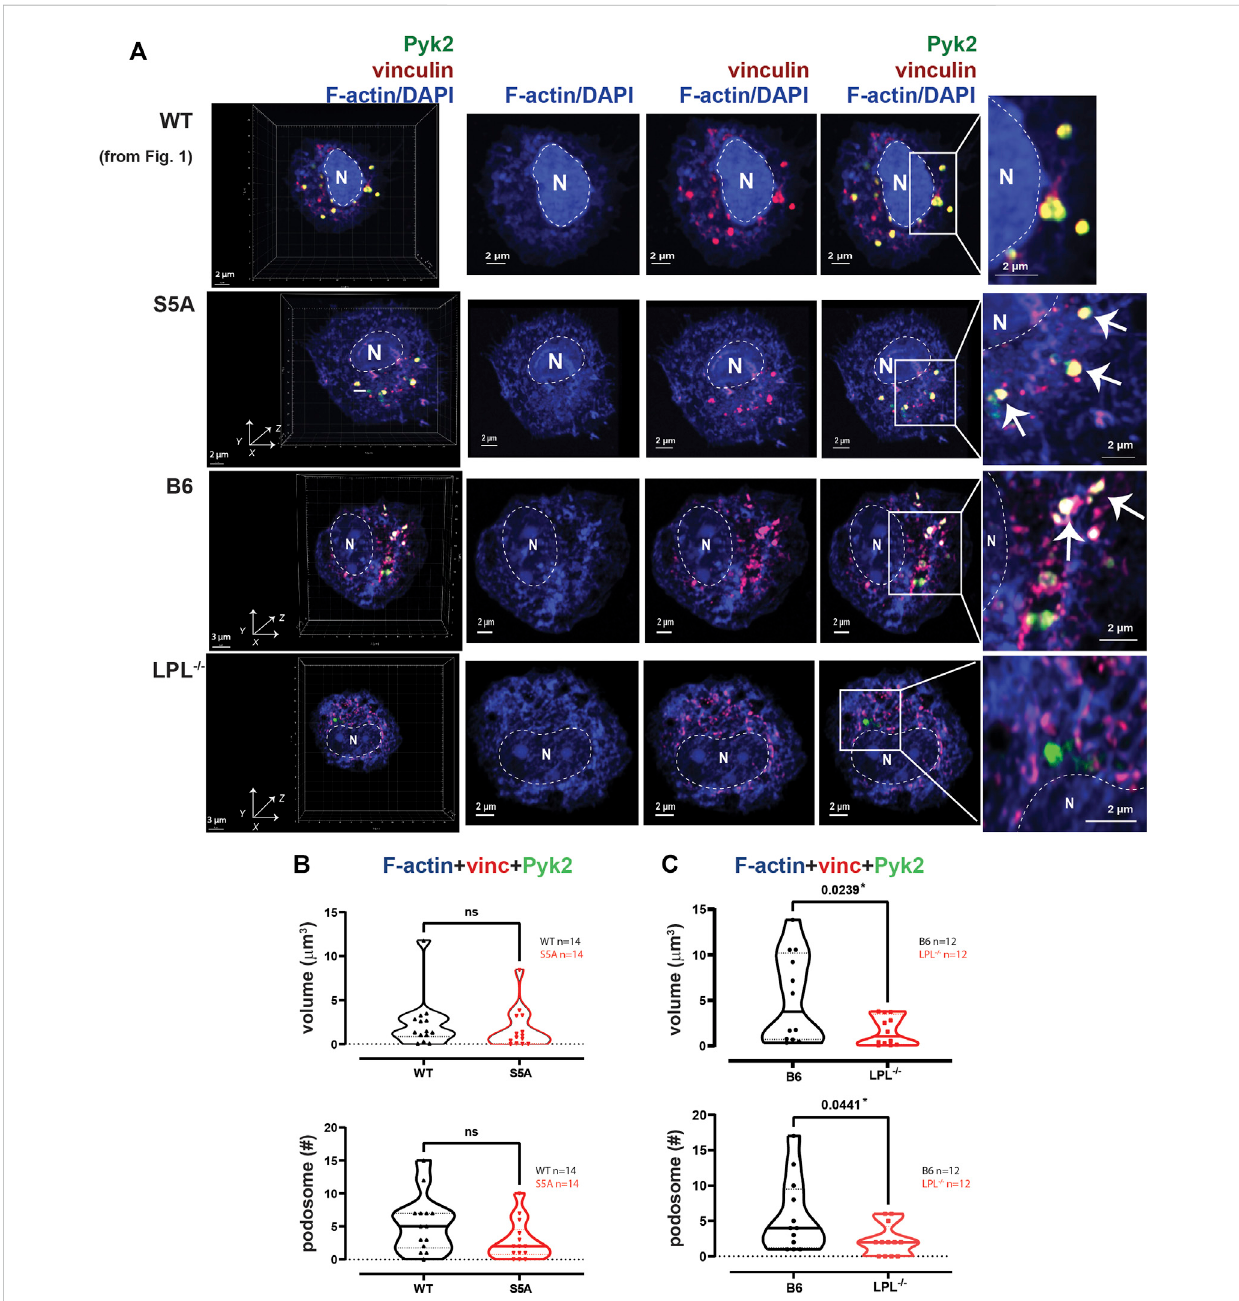
FIGURE 2 Podosome formation after serum stimulation requires LPL. (A) Co-localization of Pyk2 (green), vinculin (red) and F-actin (blue) in serum-stimulated AMsfrommatchedWTandS5AorB6andLPL − / − mice. Farleftpanels show3Dreconstruction ofZ-stackconfocal micrographs. The “ WT ” cell(toprow)is the same cell shown in Figure 1. Overlays of vinculin with F-actin and of Pyk2 with vinculin + F-actin are shown to indicate how “ volumes ” are derived in subsequent analyses. Podosomes are aggregates in which all three proteins are co-localized (arrows). Images shown are 2D XY projections of the z-stacks. DAPI was used to image nucleus ( “ N ” and dotted line). Grids show 2 μ m increments and are optimal for size assessment; scale bars in subsequentpanelsarederivedfromgrids. (B) Volumesofaggregatesofco-localizedF-actin+vinculin+Pyk2,andthenumberofaggregates ≥ 0.07 μ m 3 inAMsfrommatchedWTandS5Amice. (C) Volumesofaggregatesofco-localizedF-actin+vinculin+Pyk2,andthenumberofaggregates ≥ 0.07 μ m 3 in AMsfrommatchedB6andLPL − / − mice. (B,C) EachsymbolrepresentsthevolumecalculatedfromoneAM;n=numberofcellsanalyzed.Imagesacquired from two independent experiments. p -values determined by Mann-Whitney; ns = non-signi fi